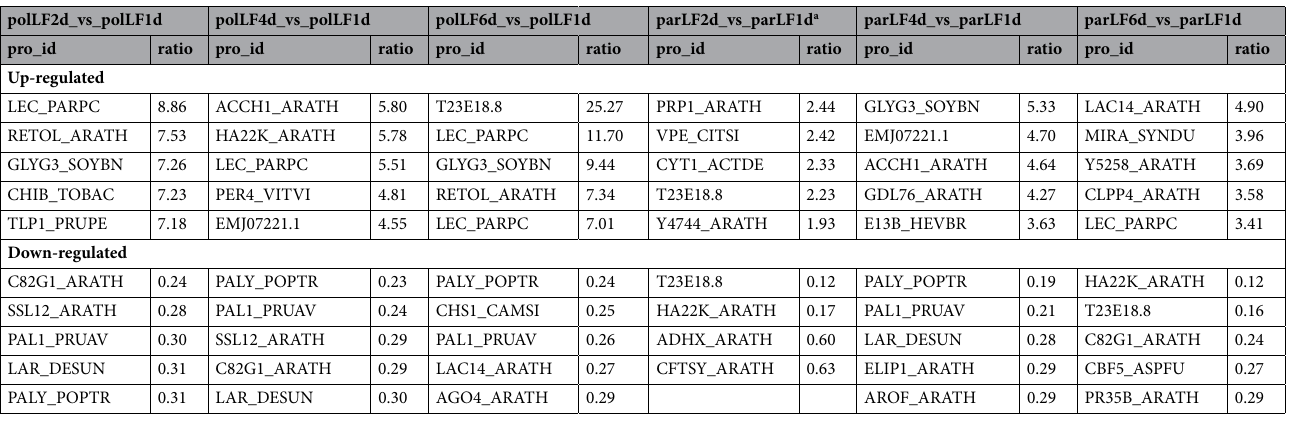
Table 4. Top five up-regulated and down-regulated proteinds identified in polLFs and parLFs by iTRAQ. a Only four down-regulated proteins identified in parLF2d compared to parLF1d.